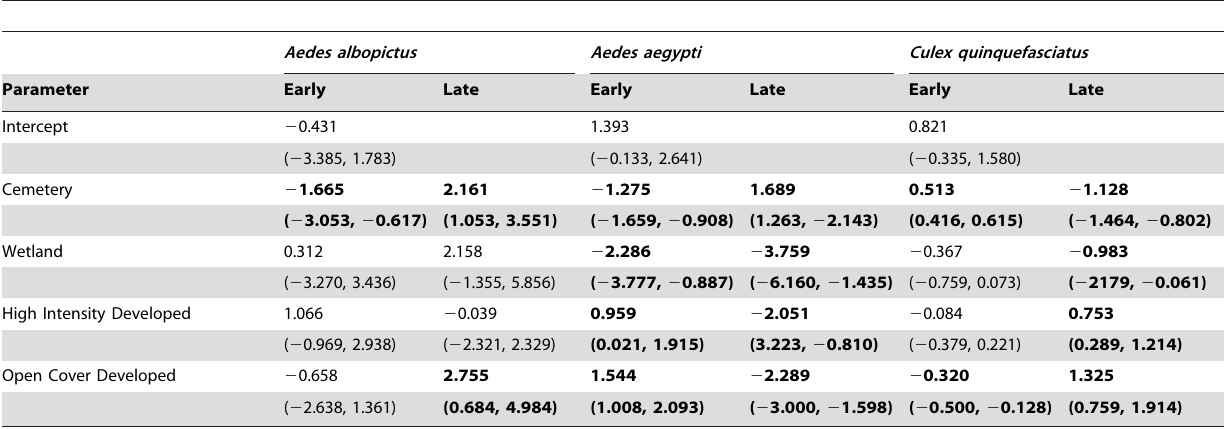
Table 4. Posterior parameter estimates (with 95% CI) for models describing the relative importance of land cover (200-m buffer) in explaining variation in larval abundance across the rainy